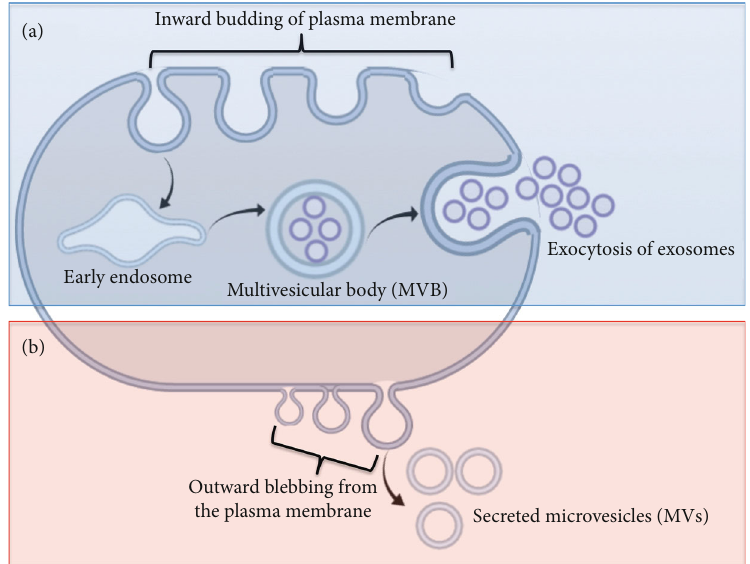
Figure 1: Biogenesis of extracellular vesicles (EVs). Section (a) describes the biosynthesis of exosomes, and section (b) shows the generation of microvesicles